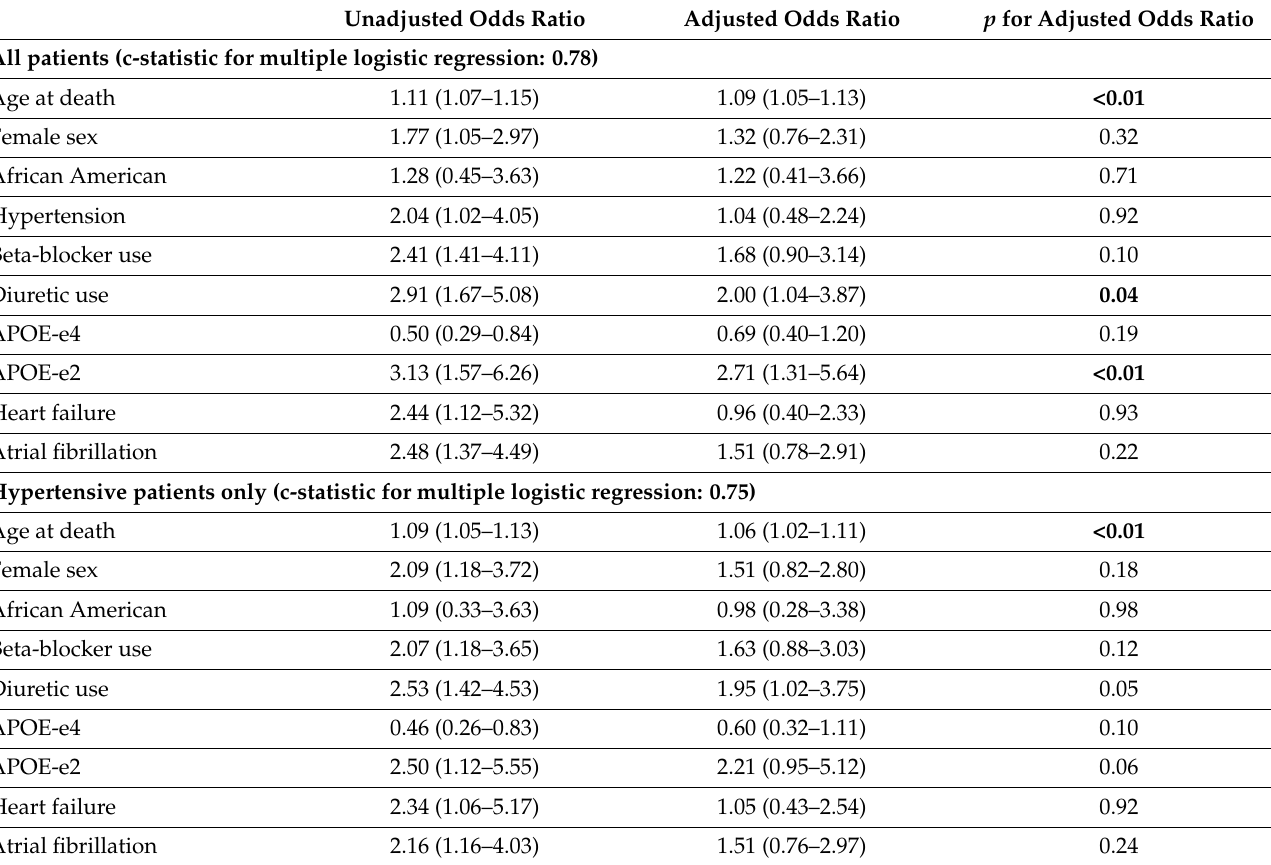
Table 2. Predictors of resilience to Alzheimer’s disease (AD) in 1373 participants in the National Alzheimer’s Coordinating Center (NACC) autopsy data with neuropathological evidence of